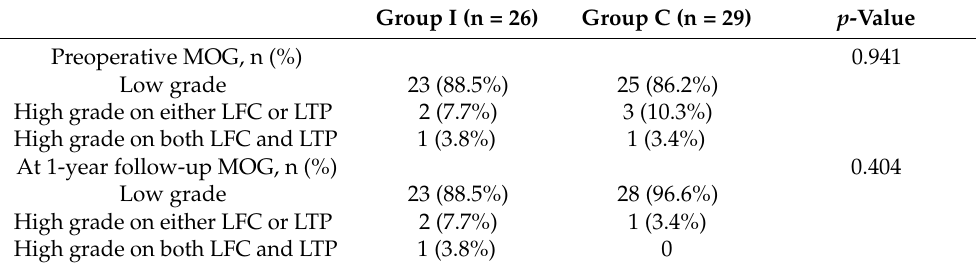
Table 4. Cartilage status.